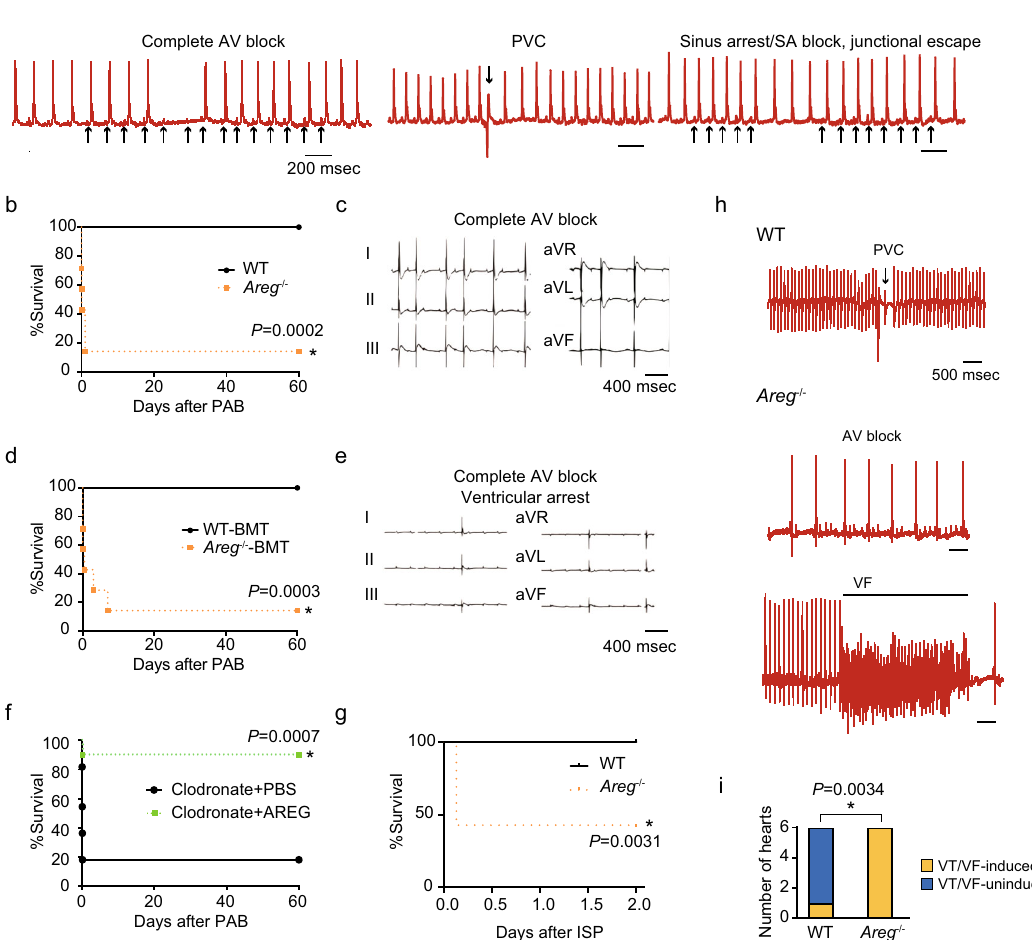
Fig. 2 Areg de fi ciency leads to abnormal cardiac electrical conduction at steady-state and lethal arrhythmias under cardiac stress. a ECGs from freely moving Areg − / − mice recorded using telemetry. Spontaneous AV block, PVCs, and sinus arrest or SA block were observed in Areg − / − mice. Bars indicate 200 msec. b Survival rates among WT and Areg − / − mice after PAB. * P < 0.001, log-rank test. c Representative ECG from an Areg − / − mouse showing complete AV block and ventricular arrest after PAB. d , e BM chimeric mice that received WT (WT-BMT) or Areg − / − ( Areg − / − -BMT) BM were subjected to PAB. Survival rates after PAB are in d . * P < 0.001, log-rank test. In e , a representative ECG from an Areg − / − -BMT mouse after PAB is shown. f Survival curves for clodronate-treated mice with or without continuous administration of AREG (5 μ g/day) from 24 h before PAB. n = 10 in each group. * P < 0.01, log-rank test. g , h WT and Areg − / − mice were intraperitoneally administered isoproterenol (bolus, 5 mg/kg). Survival rates are shown in g . In h , representative ECGs from WT and Areg − / − mice are shown. * P < 0.05, log-rank test. i Numbers of Langendorff-perfused hearts that developed VT/VF. * P < 0.01 ( χ 2